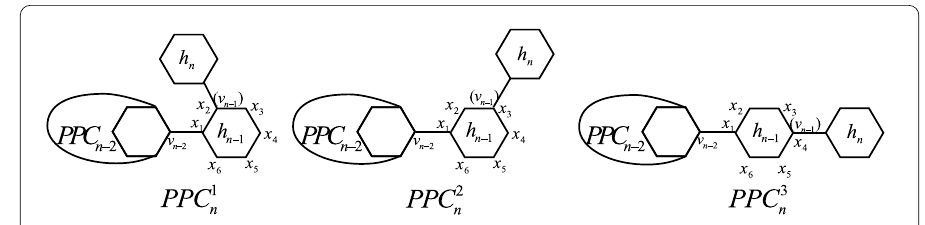
Figure 2 Three types of local arrangements in a polyphenyl chain